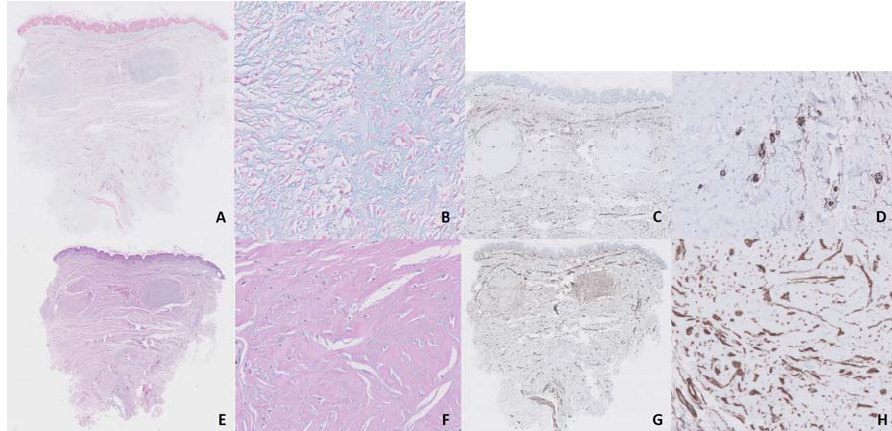
Figure 3. After treatment with a low ‐ dosage regimen of UVA ‐ 1 phototherapy, we observed a reduction in mucin ( A and B , 10× and 40×, respectively, alcian blue staining), neoangiogenesis ( C and D , 10× and 40×, respectively, CD34 staining), denser and less disorganized collagen ( E and F , 10× and 40×, respectively, hematoxylin–eosin staining) and a reduction in cellularity ( G and H , 10× and 40×, respectively, vimentin staining) in comparison with Figure